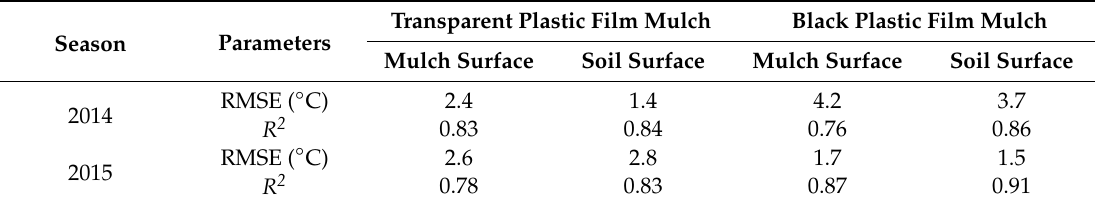
Table 5. The root mean square errors (RMSE) and coe ffi cient of determination ( R 2 ) in simulated and observed daily temperatures (on mulch surface and soil surface) for the transparent plastic film mulch and black plastic film mulch treatments at Wuwei,